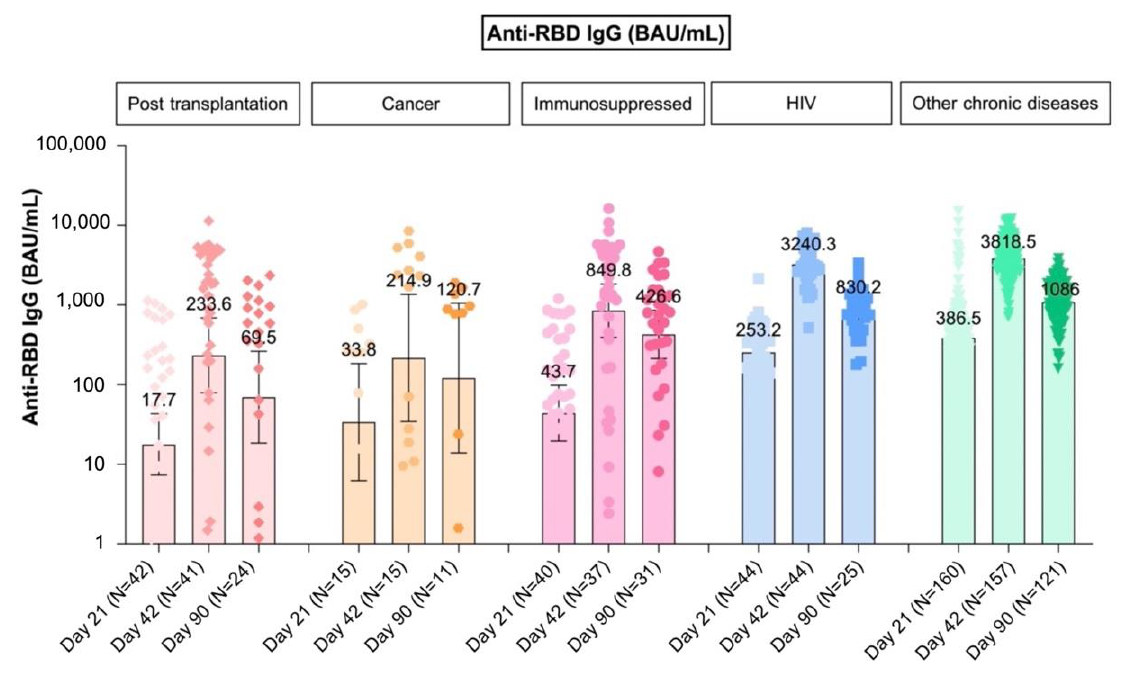
Figure 2. GMs of anti-RBD IgG after BNT162b2 vaccination at day 21, day 42 (14 days after 2-dose of vaccine), and day 90.